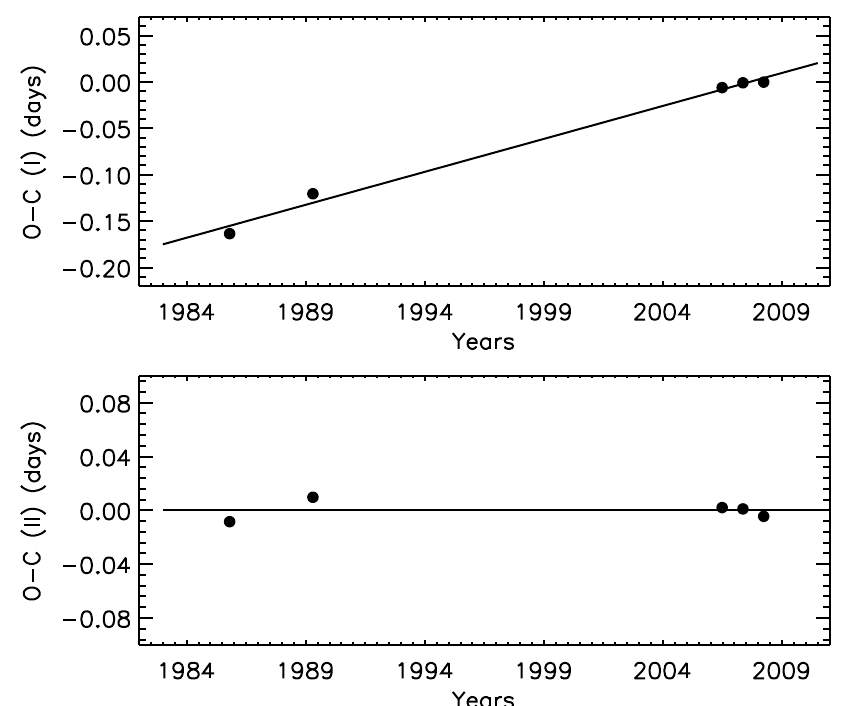
Fig. 1. The O–C (I) variation in time (top panel) and the differences from the linear fit (bottom